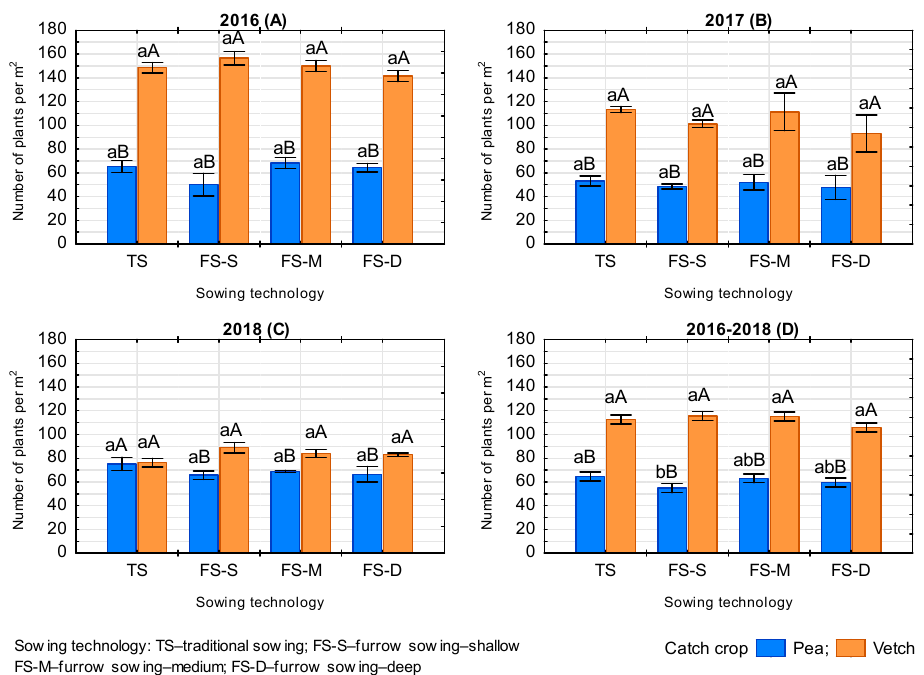
Figure 8. Interaction between factors in shaping the plant density 10 days after sowing seeds [pcs. m − 2 ]. a,b—homogenic groups HSD ( p = 0.05) interaction for sowing method/species (the differences between the four methods of sowing separately for pea and for vetch). A,B—homogenic groups HSD ( p = 0.05) interaction for species/sowing method (differences between pea and vetch for each sowing method).